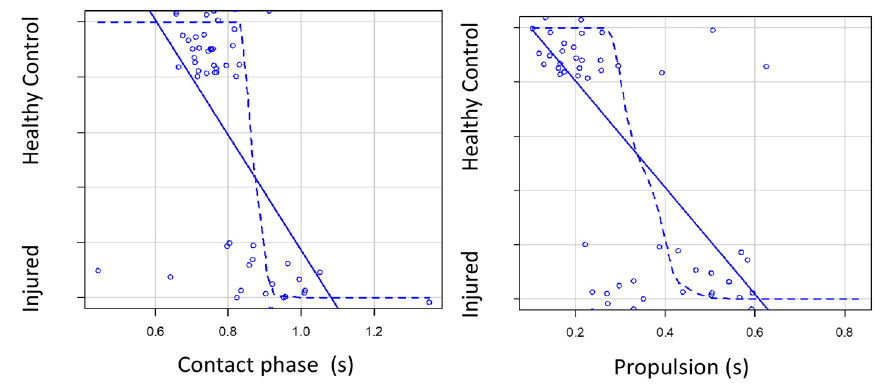
Figure 3. Scatter plots on the variables with the most significant results. Constant line is the linear regression and spot line is the logistic regression of the